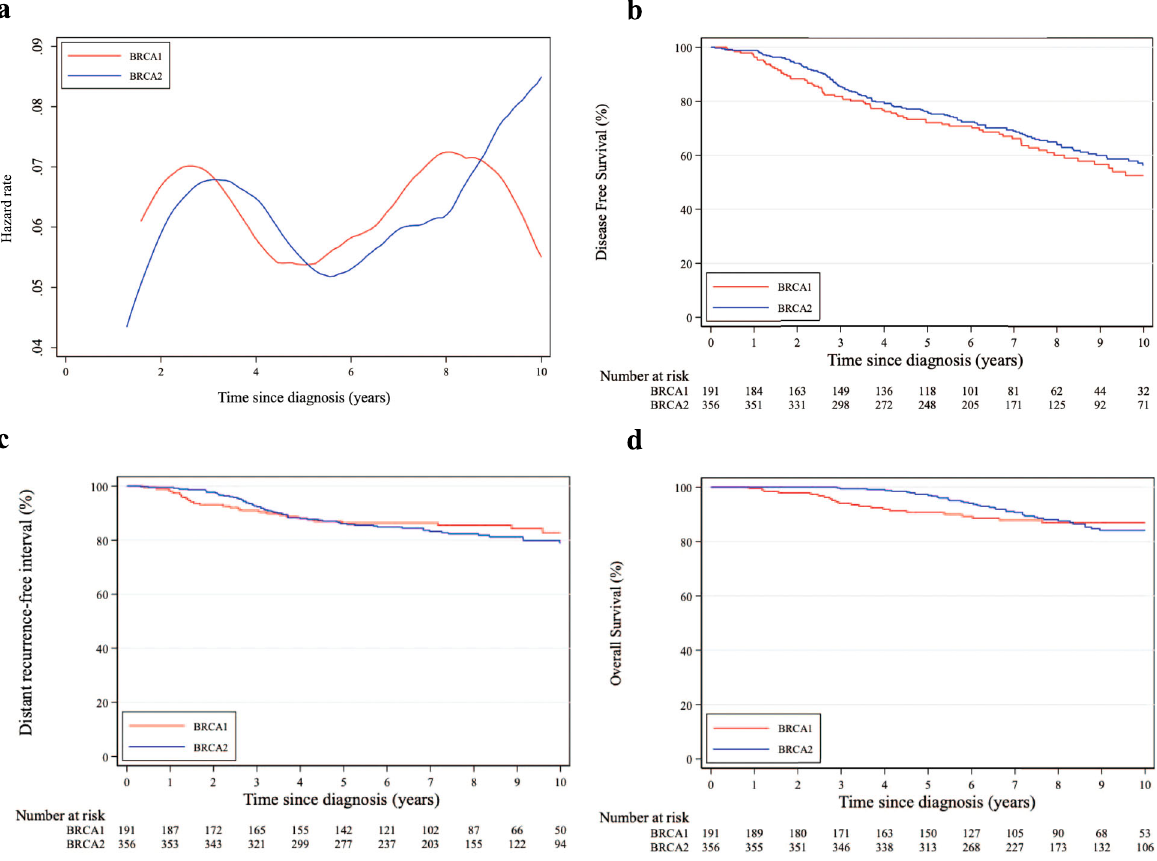
Fig. 2 Comparison between patients with germline BRCA1 and BRCA2 pathogenic variants and hormone receptor-positive disease. a Epanechnikov Kernel-Smoothed annual hazards of recurrence overall; b Disease-free survival; c Distant recurrence-free interval; d Overall